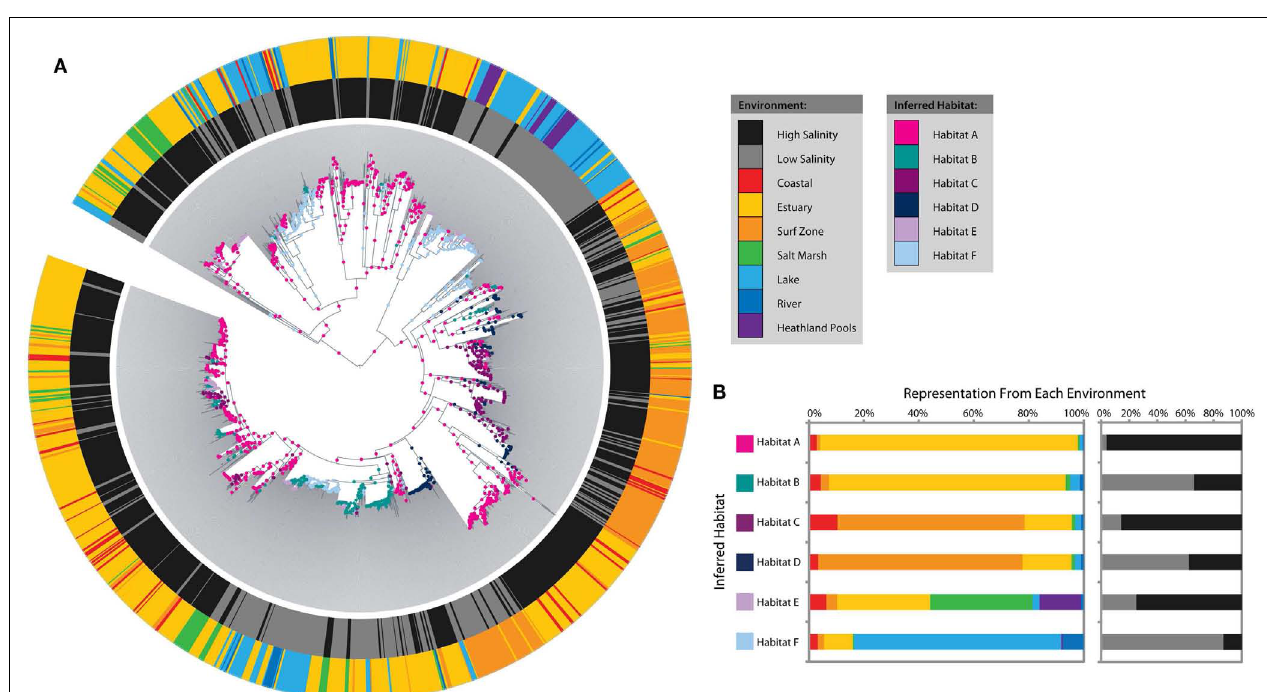
( ≥ 15ppt) or low ( < 15ppt) salinity and the outer ring indicates the microenvironment. Ecological habitats predicted by the model are shown as nodes on the tree. (B) The distribution of each habitat among microenvironments and salinity.The habitat and environment colors match the legend in (A)